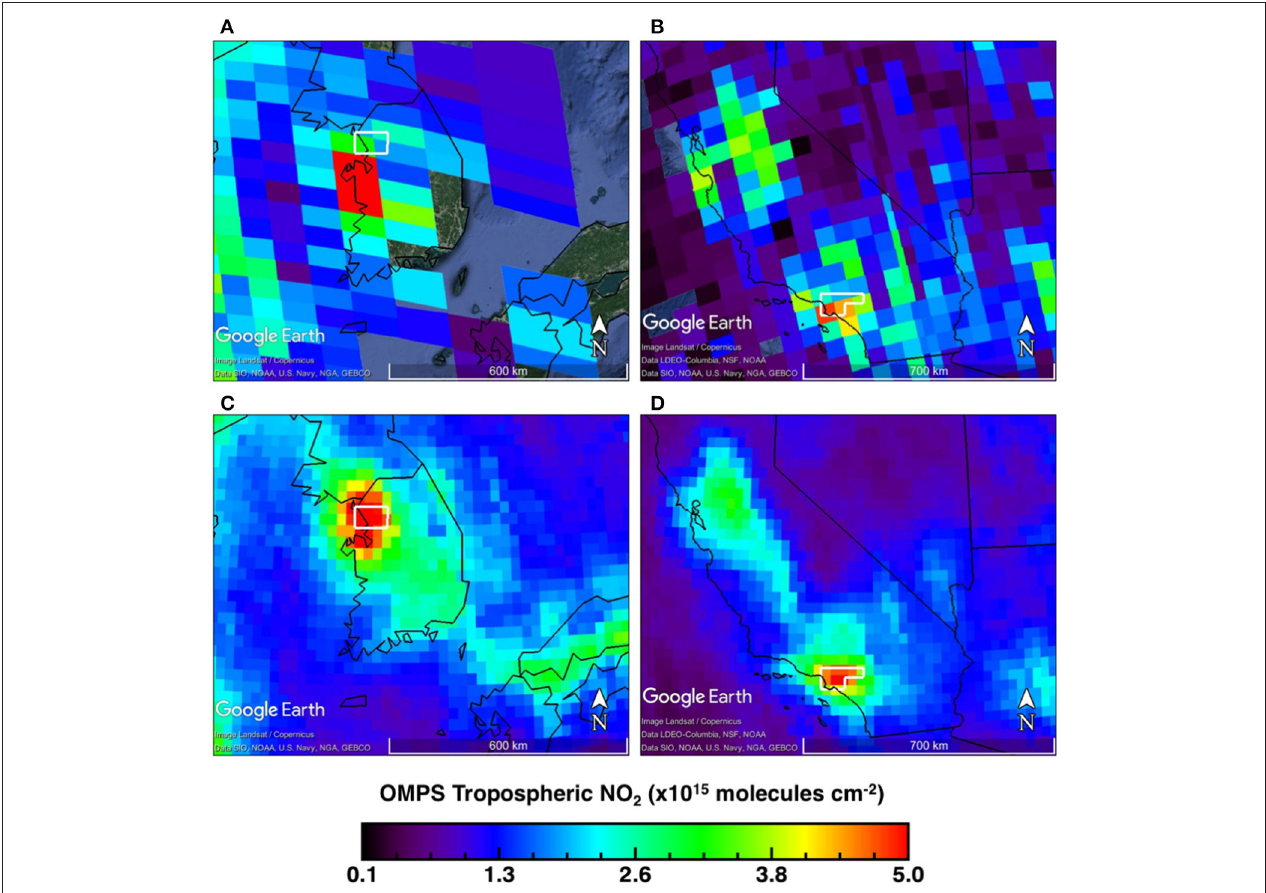
FIGURE 2 | Tropospheric NO 2 data from OMPS NM aboard Suomi-NPP for single overpasses on (A) June 9th 2016 over South Korea and (B) June 27th, 2017 over California. The monthly averaged 0.25 ◦ × 0.25 ◦ tropospheric NO 2 from OMPS NM is shown for (C) June 2016 over South Korea and (D) June 2017 over California. White polygons in each map outline the area of the GeoTASO flights.